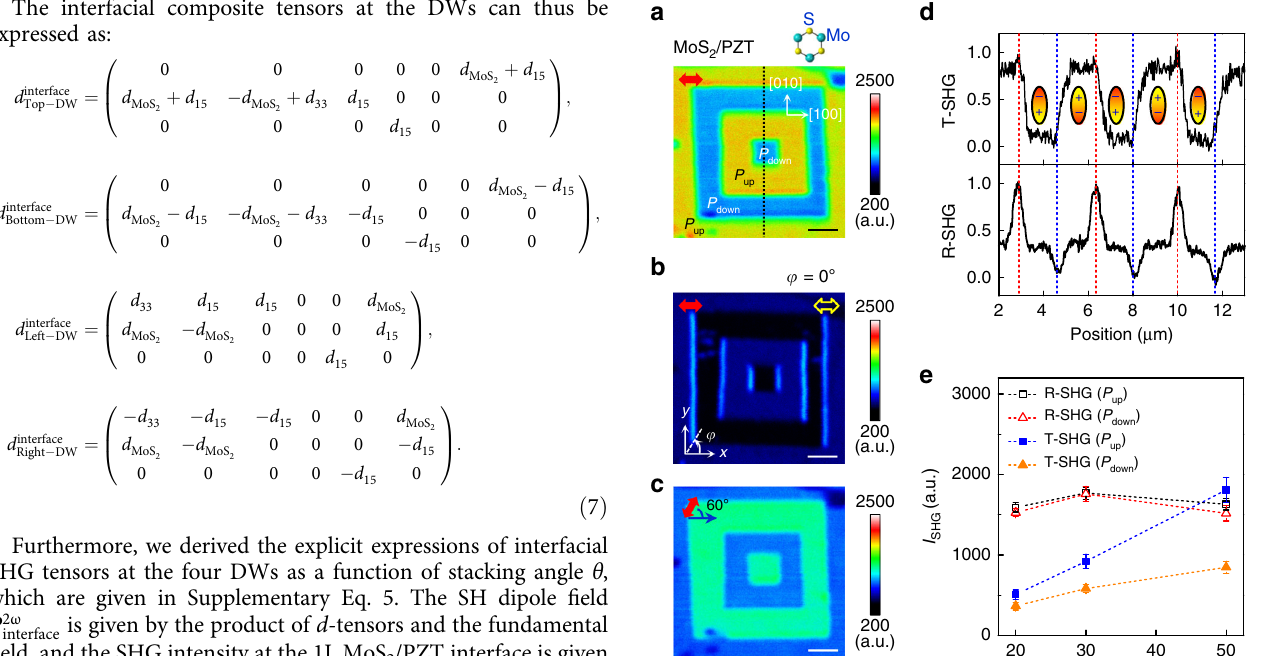
transmission mode. Only when a horizontal analyzer is applied does the SHG signal for the vertical ([010]) DWs become appreciable (Fig. 4b), similar to that observed in the re fl ected mode (Fig. 2h). We also note that the relative strength of the SHG intensity between the regions of the P up and P down domains depends on the polarizer angle (Fig. 4c). Figure 4d shows the cross-sectional SHG signal pro fi les for the same region in both transmission (Fig. 4a) and re fl ection (Fig. 2e) modes. For com- parison, the signals are normalized to the intensity difference between the even ( I even ) and odd ( I odd ) horizontal DWs, de fi ned as ( I − I even )/( I odd − I even ). It clearly illustrates that the signal contrast is either tailored by the uniformly polarized domains or the DWs in these two detection modes.